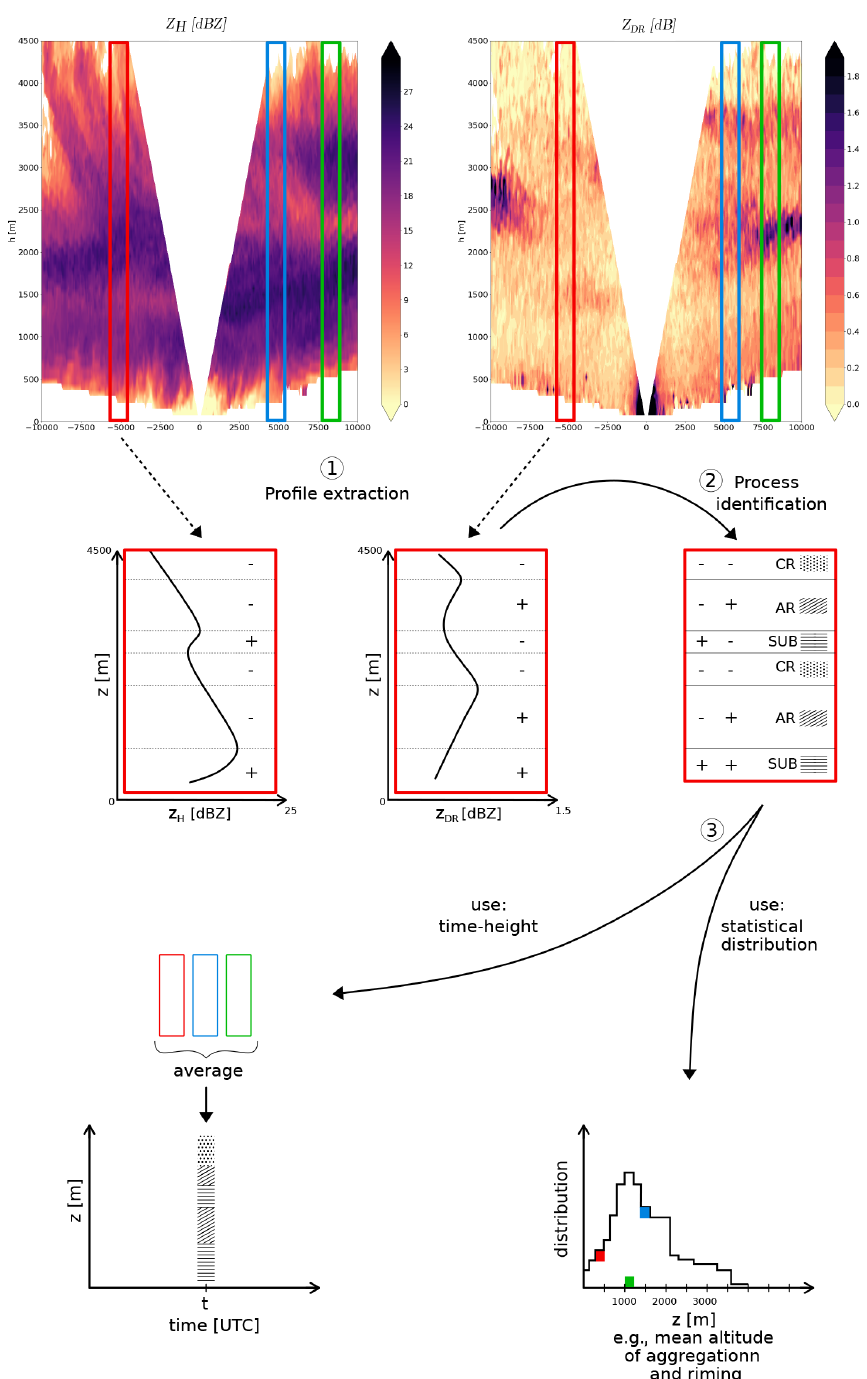
Figure 1. Schematic of the PIVS method. The two top panels are examples of RHI scans of Z H and Z DR .